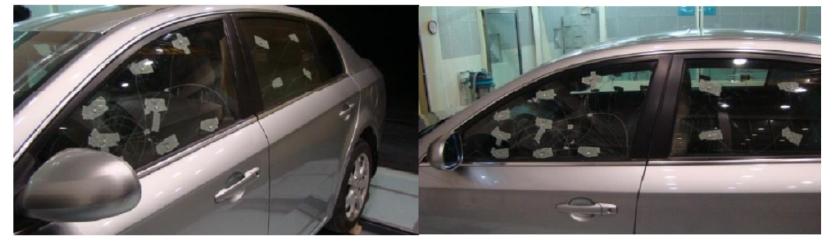
Figure 3. Layout to measure surface pressure.